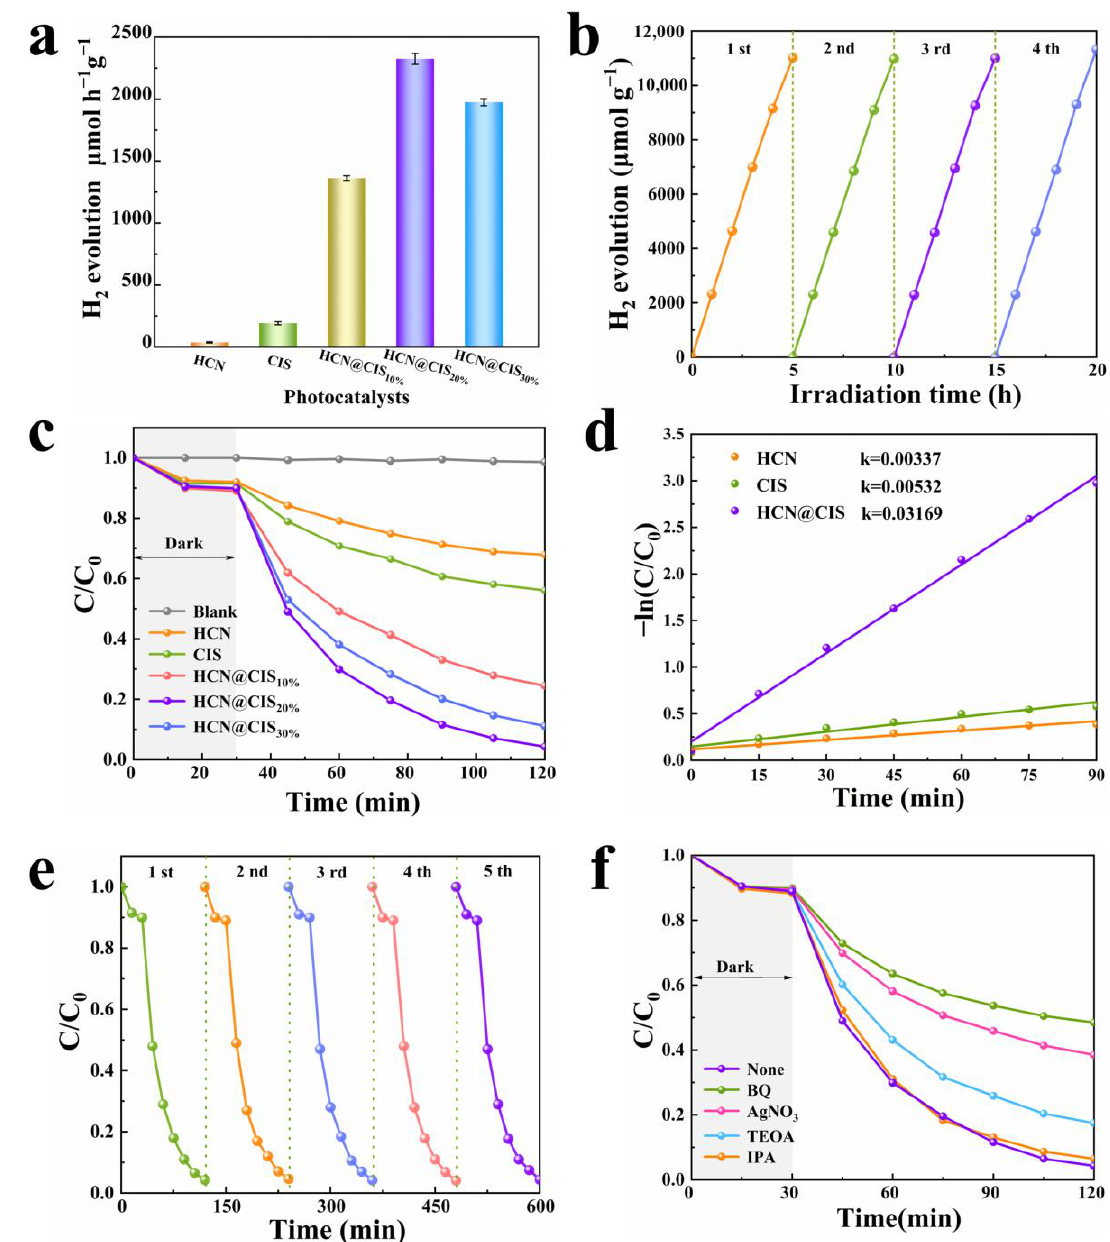
Figure 5. Photocatalytic H 2 evolution for all samples ( a ) and H 2 production cycle test of HCN@CIS ( b ). Photocatalytic degradation of OTC for all samples ( c ) and the corresponding apparent reaction rate constants k ( d ). Cycling tests ( e ) and free radical quenching experiments ( f ) on HCN@CIS degraded OTC.